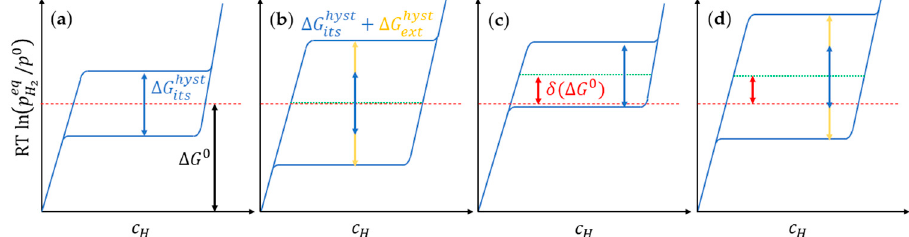
Figure 1. A sketch to represent hysteresis and thermodynamical bias effects on hydrogen sorption isotherms. From the left to the right: ( a ) Reference bulk material showing an intrinsic hysteresis; ( b ) The effect of additional extrinsic hysteresis that increases the separation between absorption and desorption curves with no bias induction; ( c ) a real thermodynamical bias induced, e.g., by interface effects; ( d ) a more realistic case where both extrinsic hysteresis and thermodynamical bias are present.